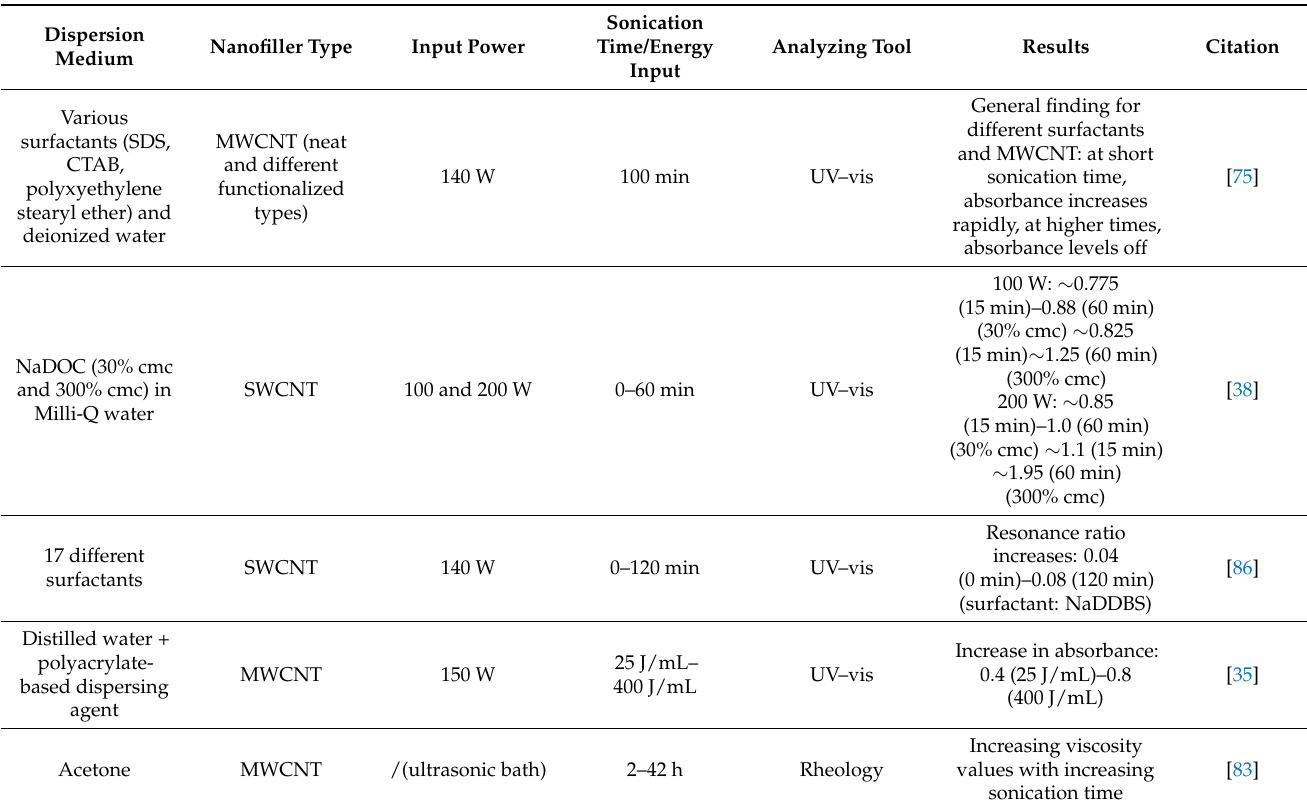
Table 4. Overview of the literature with respect to monitoring the dispersion state of CNT, including information on the me- dia into which CNT were dispersed, the CNT type, sonication power, energy input or sonication time, and characterization method applied, with a short summary of the results and the according citation for further